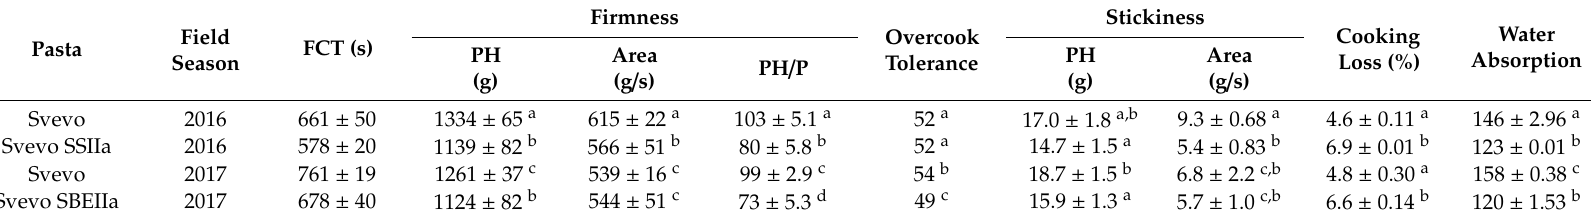
Table 3. Pasta cooking properties of HA and control